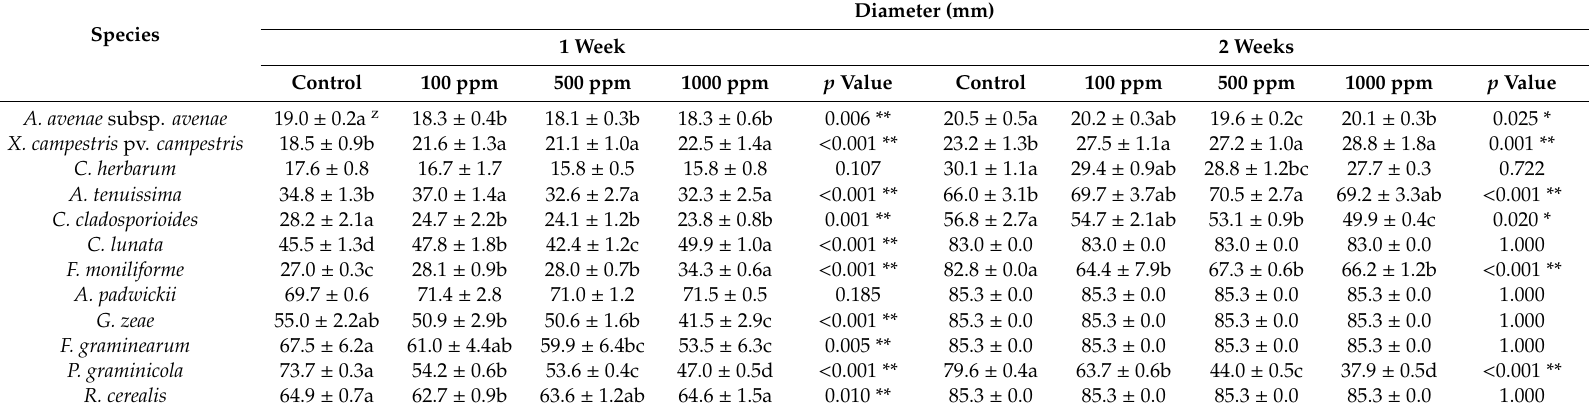
Table 5. Diameter of radial growth of various pathogen species against chrysoeriol